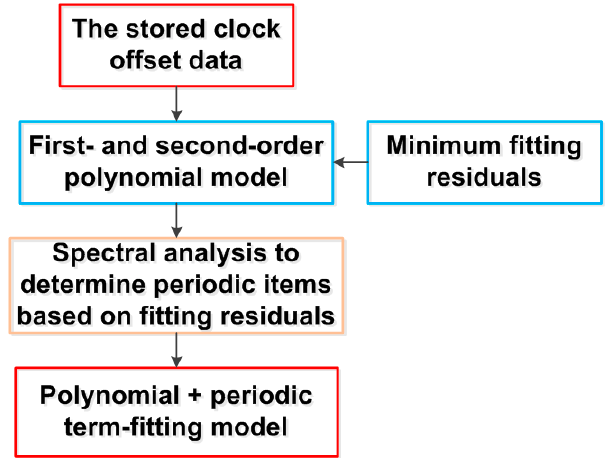
Appl. Sci. 2019 , 9 , x FOR PEER REVIEW Figure 1. Diagram of the adaptive prediction clock model. Figure 1. Diagram of the adaptive prediction clock model.